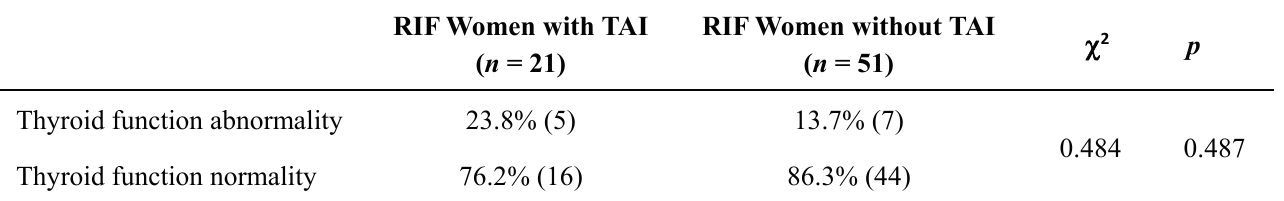
Table 2. Association of TAI and thyroid function abnormality in women with RIF.